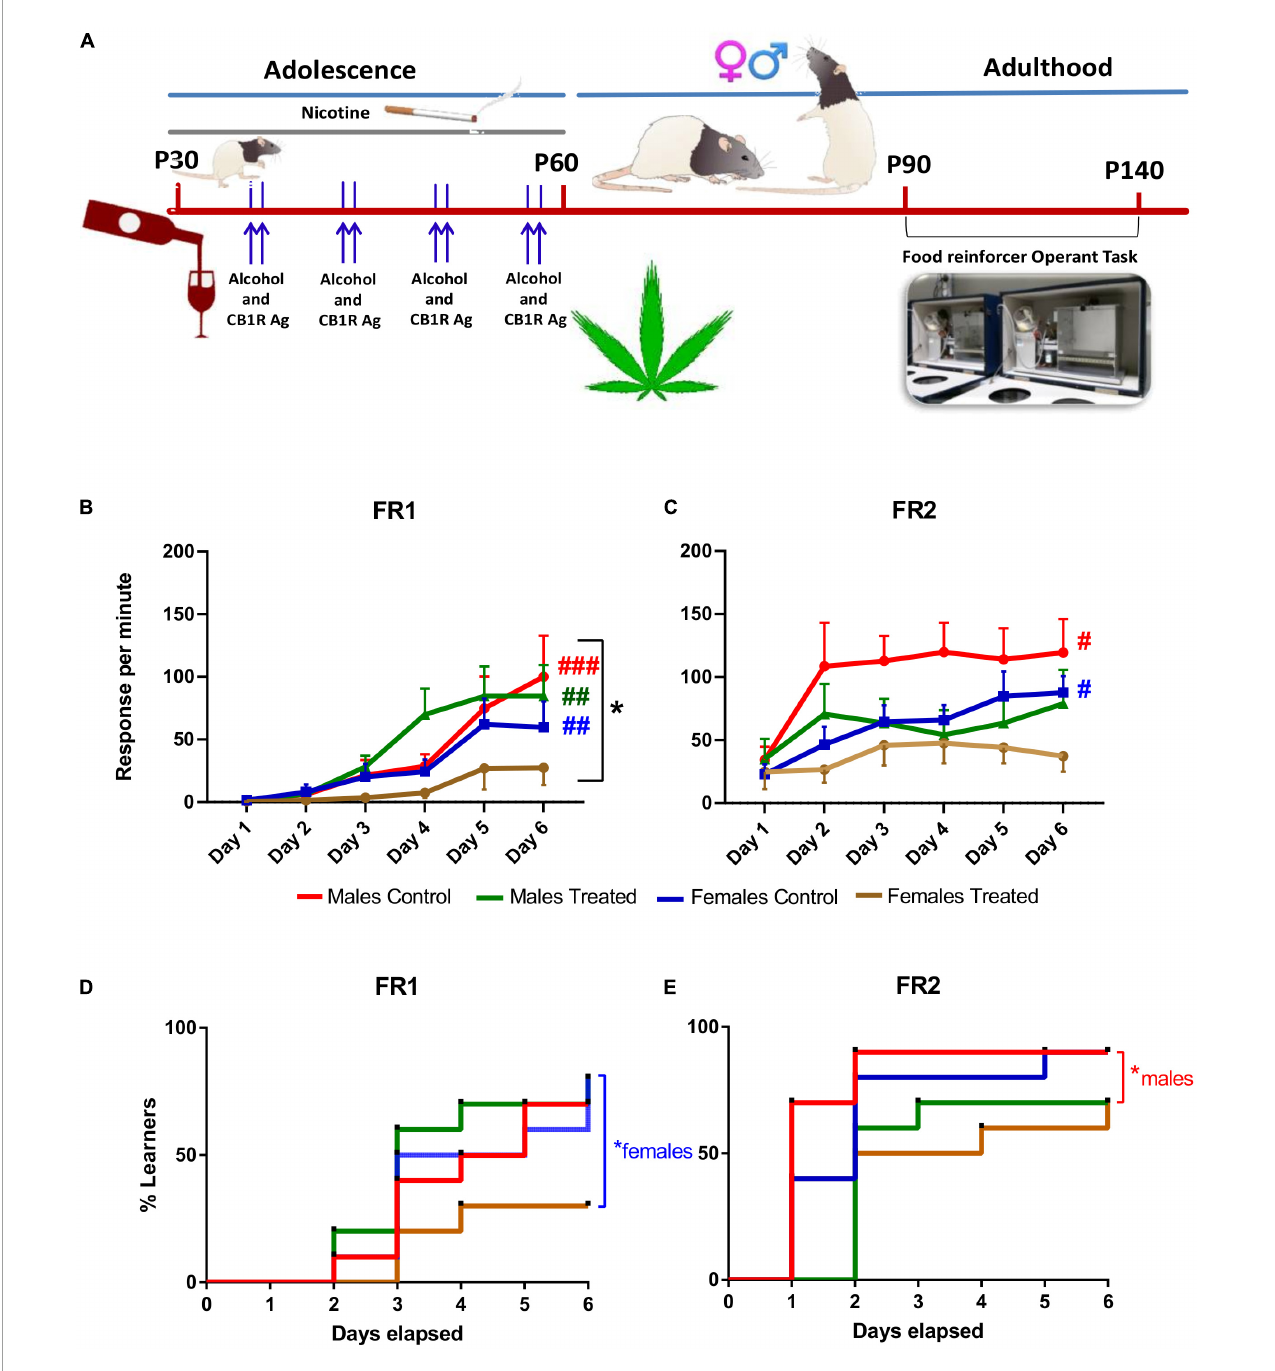
FIGURE1 Long-term term effect of adolescent binging on alcohol and cannabinoid and daily exposure to nicotine on learning and motivation in rats. (A) The chronic treatment was initiated at P30 with daily nicotine administration (0.3 mg/kg., i.p.) for 30 days and two consecutive days once a week with ethanol (3 g/kg; i.g.) and 1.2 mg/kg CB 1/2 receptor agonist WIN 55,212-2. Rats were food restricted before each test until they reached 85% of their ad libitum body weight. Operant conditioning testing was performed at least after 30 days the end of the treatment ( > P90). (B) Rats underwent the first 6 days of testing under a FR1 schedule. Female rats made fewer presses compared to males. Control males, treated males and control females improved throughout the FR1 schedule when compared to FR1 day 1, while treated females did not. (C) After 45 days, rats underwent to a FR2 schedule. Male and Female controls improved in response per min during the FR2 while both treated male and female groups did not show an improvement during the six days of the test. * p < 0.05, Two-way ANOVA; # p < 0.01; ## p < 0.005; ### p < 0.001 generalized Kruskal Wallis analysis. (D) Instrumental learning performance was significantly decreased in polydrug-treated females during FR1 and in (E) polydrug-treated males during FR2 compared to their respective control groups. * p < 0.05, log-rank Mantel-Cox test. i.p.: intraperitoneal; i.g.: intragastric; FR: fixed ratio.